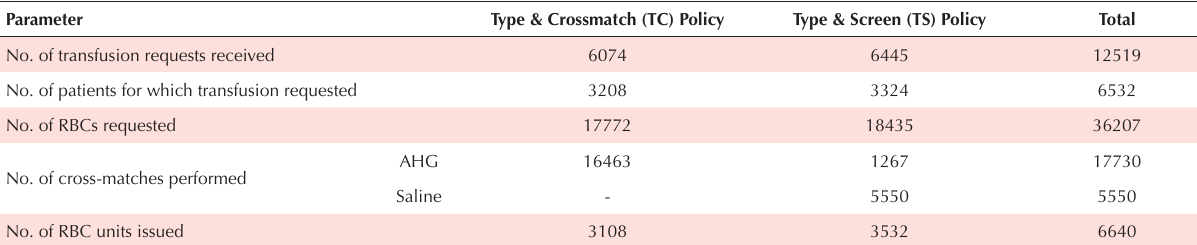
Table 1. Details of the requisition for RBC transfusion Parameter